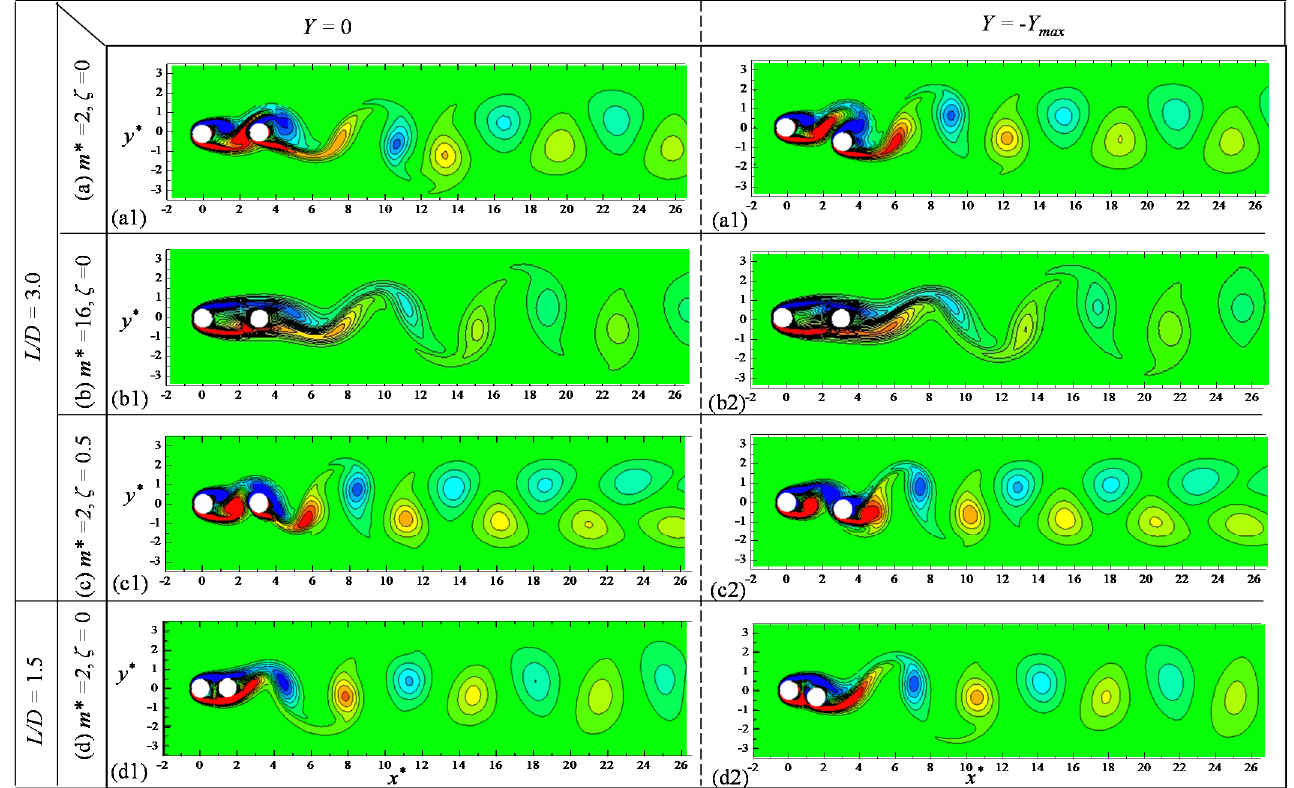
Figure 11. Vorticity contours for ( a ) m* = 2, ζ = 0, L/D = 3.0; ( b ) m* = 16, ζ = 0, L/D = 3.0; ( c ) m* = 2, ζ = 0.5, L/D = 3.0; and ( d ) m* = 2, ζ = 0, L/D = 1.5. Ur = 10.